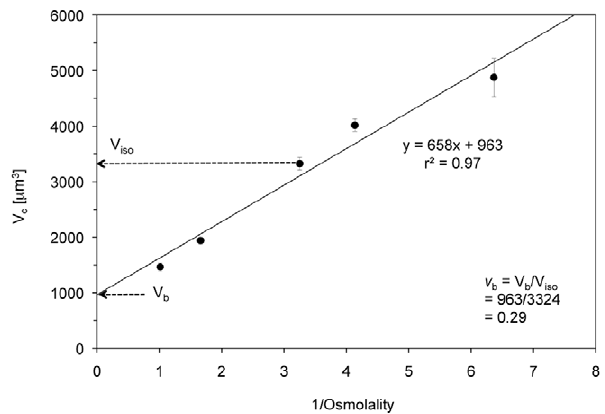
Figure 2. Boyle-van’t Hoff plot of COS-7 cells. The BvH plot displays the absolute volume as a function of the reciprocal of the osmolality of the TBS in which the cells were suspended for 5 to 7 min at 22 u C. Each point is the mean of 250 to 828 individually analyzed cells. The volumes were calculated from the measured diameters as described in the text. Data were fitted by the method of least squares.